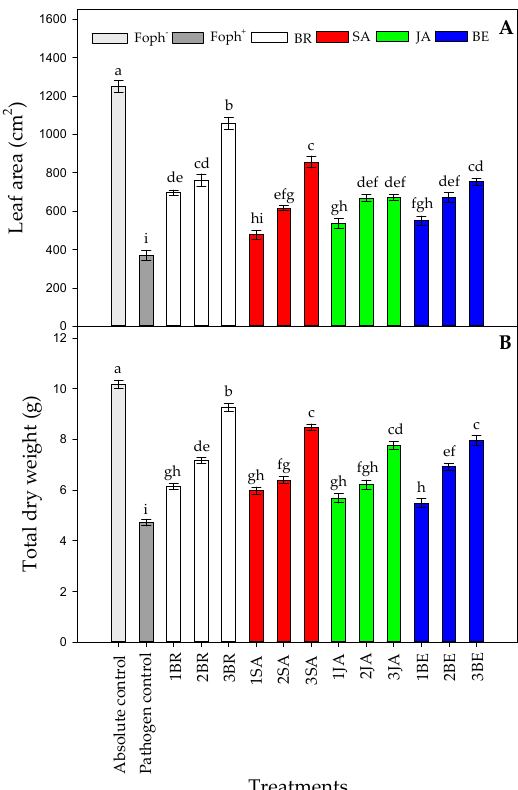
Figure 4. Effect of the different number of sprays (0, 1, 2 and 3 applications) of synthetic elicitors (Salicylic acid (SA), jasmonic acid (JA), Brassinosteroids (BR), or botanical extracts (BE)) on leaf area (LA) ( A ) and total dry weight (TDW) ( B ) in Fusarium oxysporum f. sp. physali (Foph + ) infected cape gooseberry ( Physalis peruviana L.) plants at 50 DAI. Data represent the average of ten plants ± SE per treatment ( n = 10). Bars followed by different letters indicate statistically significant differences according to the Tukey test ( p ≤ 0.05).